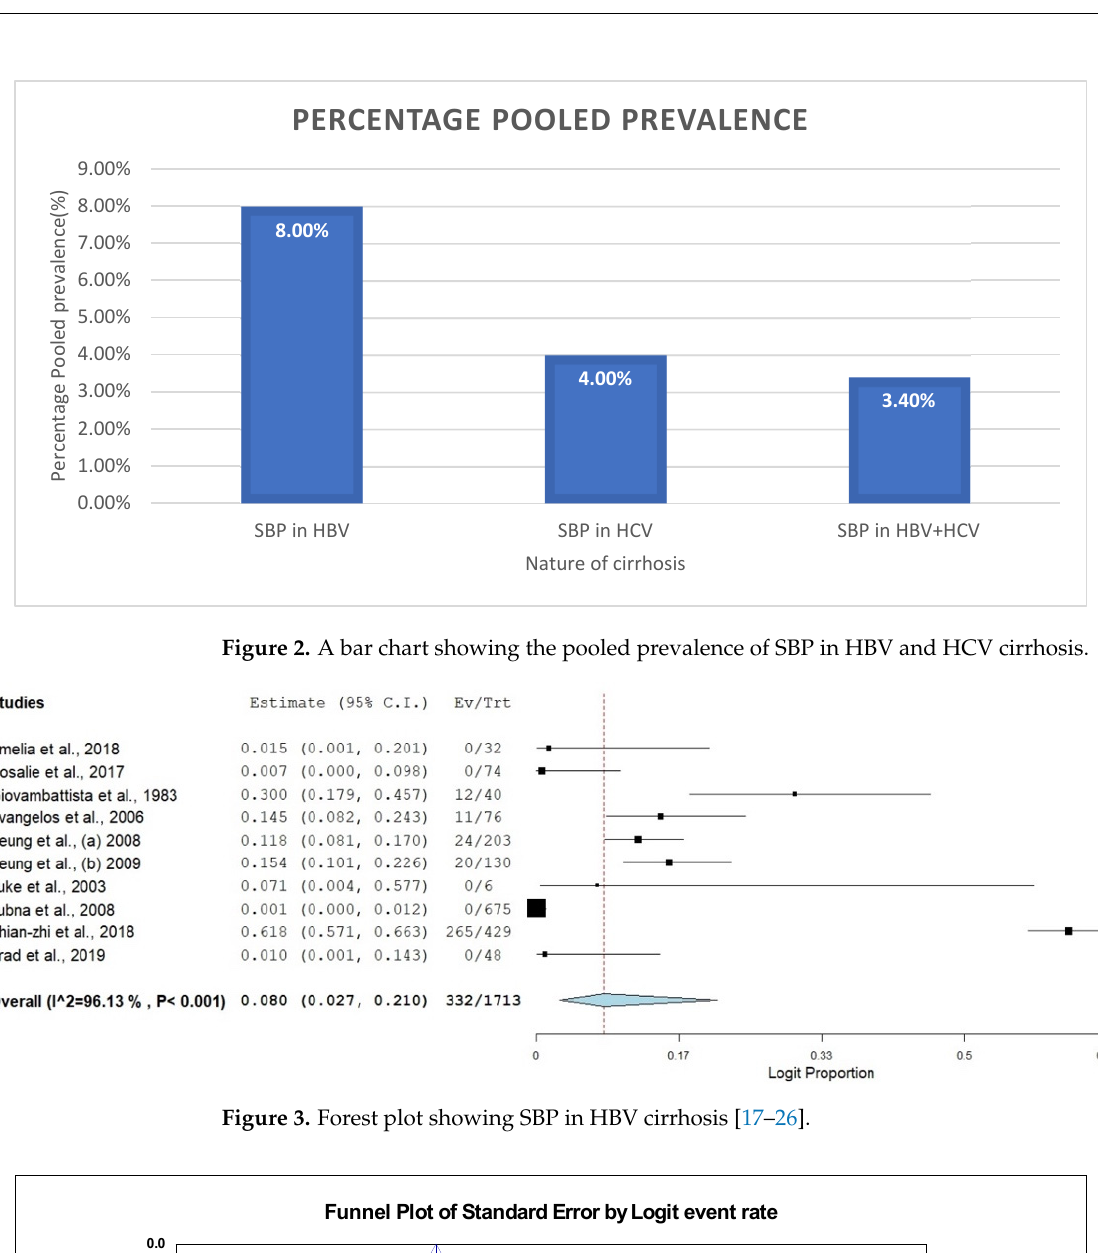
Figure 3. Forest plot showing SBP in HBV cirrhosis [17–26].